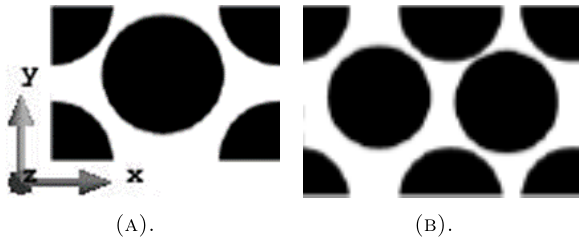
(a). (b). Figure 4. Microscale level of yarn, (A) two-fiber SEPUC-1, (B) four-fiber